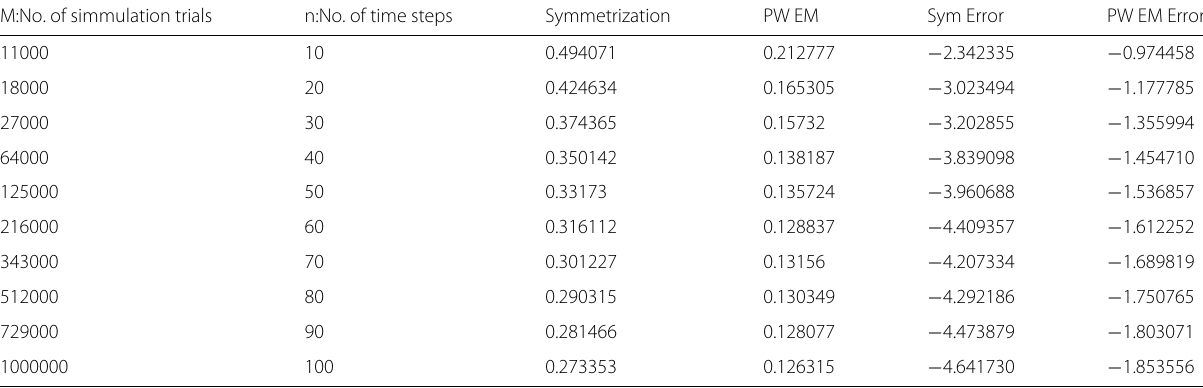
Table 1 ( X 0 , Y 0 ) = ( 0.75, 0.7 ) ,